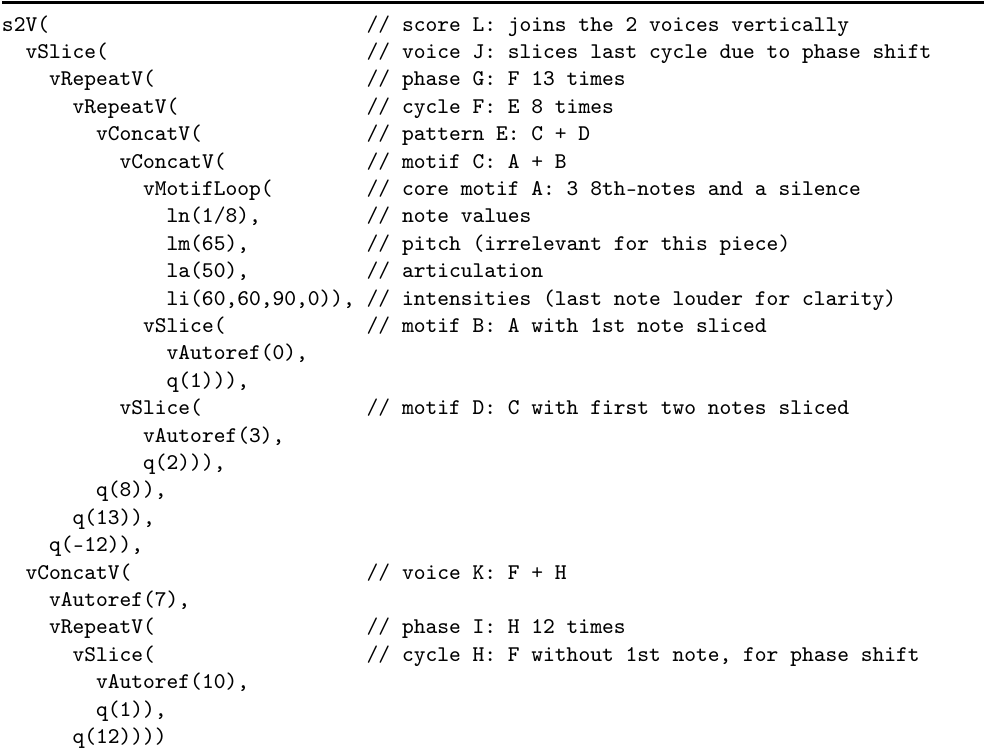
Listing 1. Decoded genotype of Clapping Music model. The uppercase letters in the comments refer to the patterns analyzed in Figure